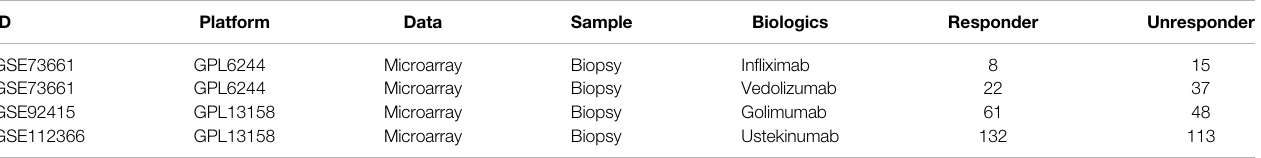
TABLE 4 | GEO datasets involved in IBD ’ s biologics response and m6A.